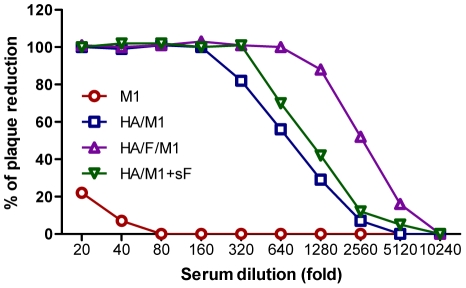
Neutralization activity against PR8.Immune sera were diluted 2-fold stepwise and incubated with virus (100 PFU) at 37°C for 1 h. A standard plaque reduction assay was performed using MDCK cell cultures.